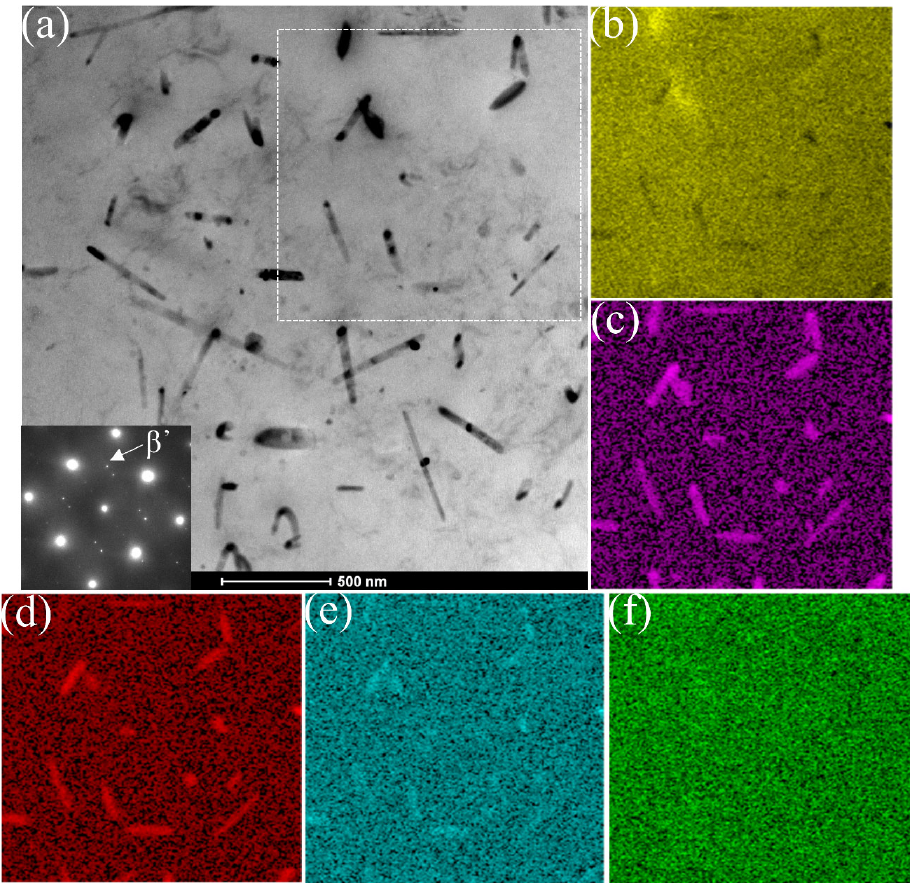
Figure 5. TEM bright-field picture of the aged Al alloy, ( b – f ) the mapping images of the atoms (Al, Si, Mg, Cu, and Zn) for the white dashed rectangle in ( a ). Mg, Cu, and Zn) for the white dashed rectangle in ( a